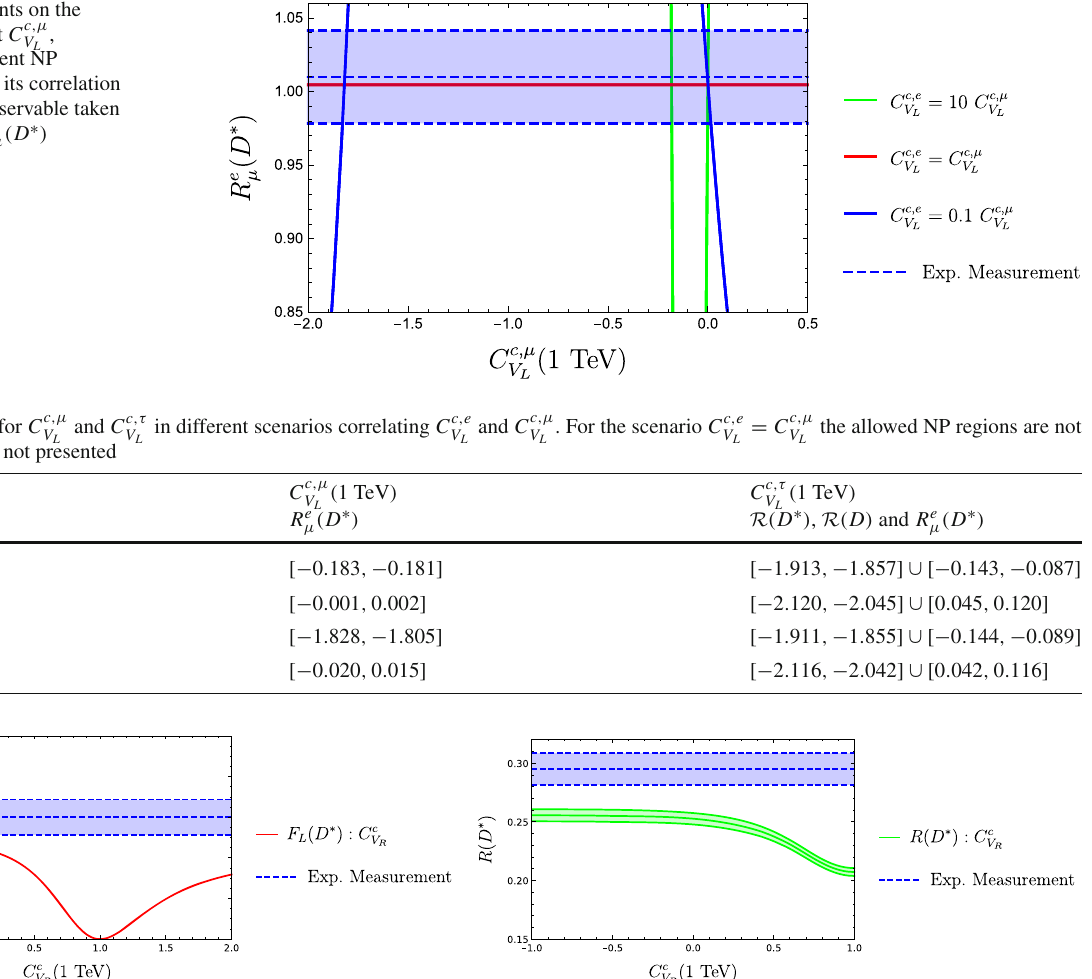
Fig. 15 Constraints on the Wilson coefficient C V